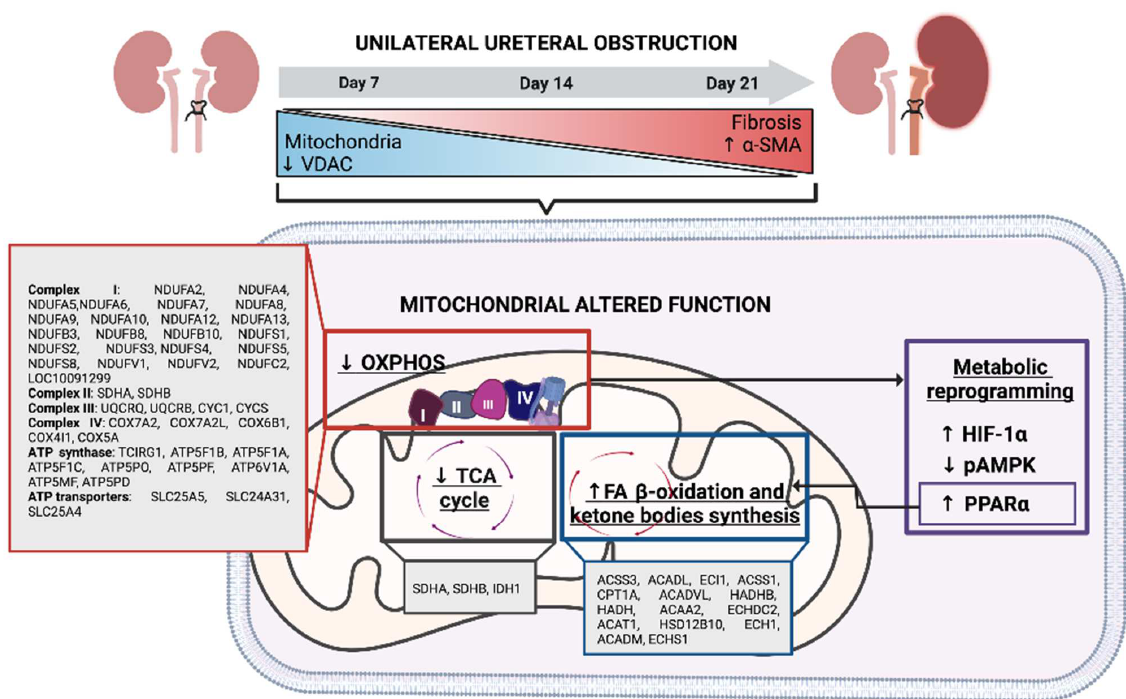
Figure 7. Integrative scheme. During the unilateral ureteral obstruction (UUO), mitochondrial VDAC decreases from 7 days after obstruction and continues during the obstruction. Mitochondrial